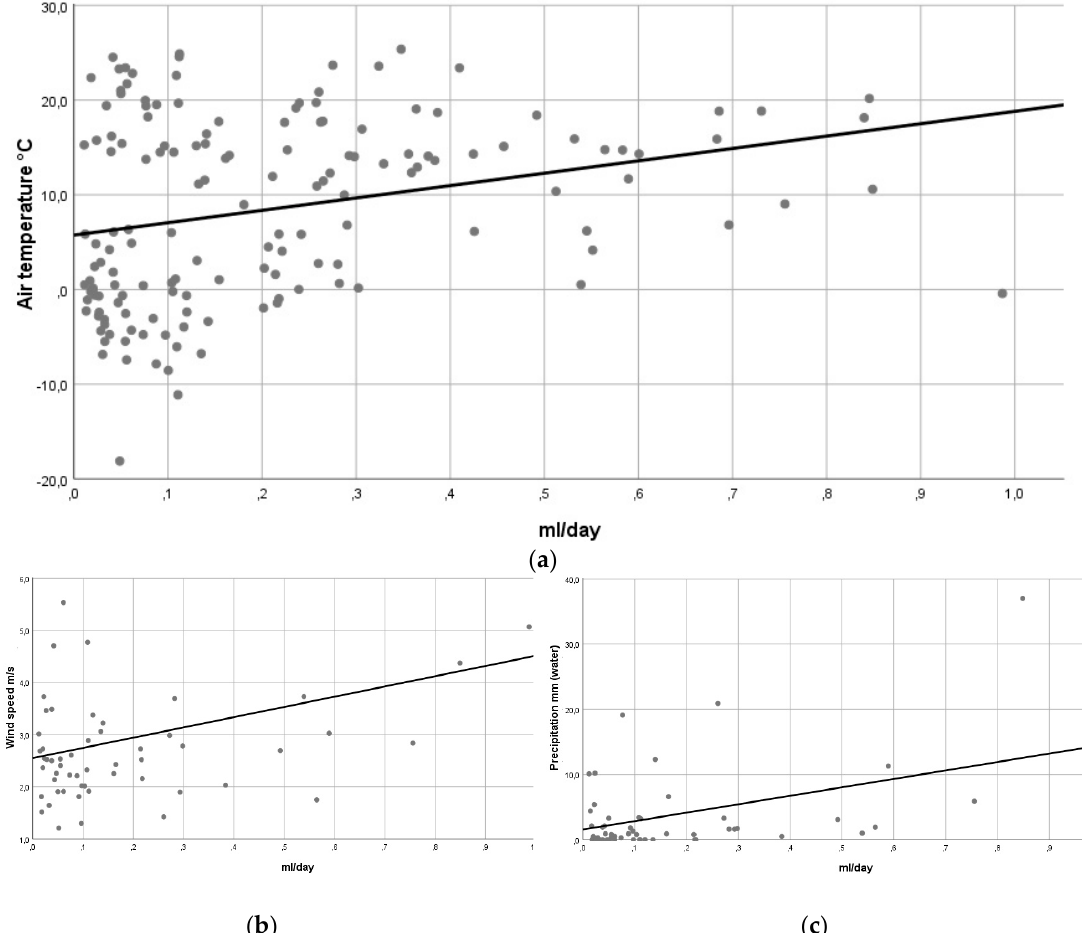
Figure 7. Linear relationship between ( a ) air temperature, ( b ) wind speed, and ( c ) water precipitation and daily sedimentation flux rate.